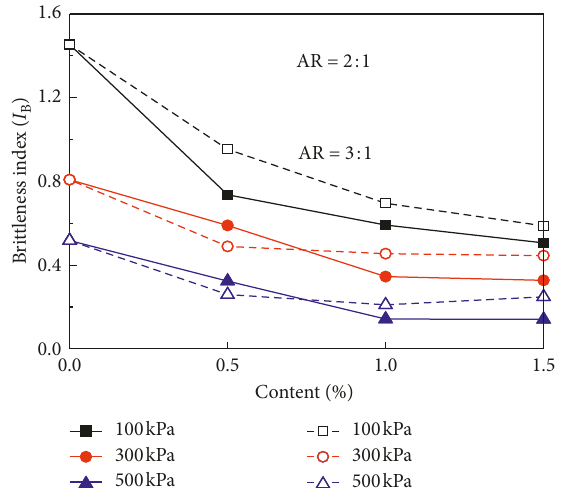
Figure 6: Variations in stiffness under the effects of fabric block content and aspect ratio.